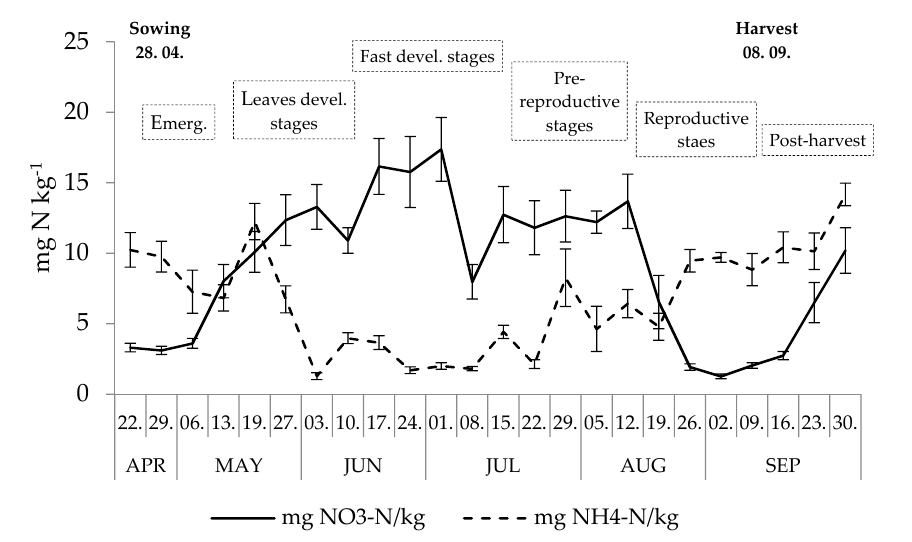
Figure 3. Content of NO 3 − -N and NH 4 + -N in the soil.